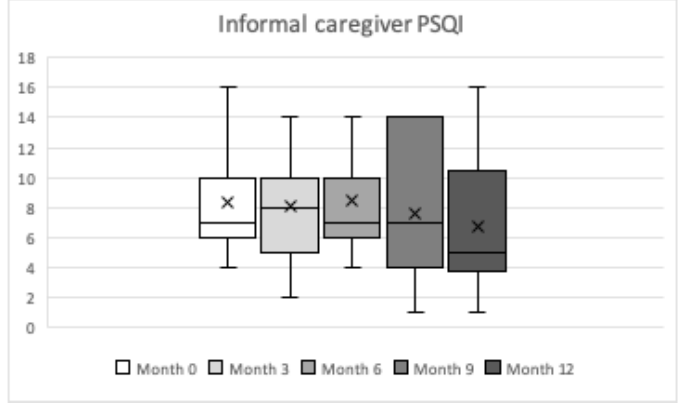
Figure 7. Informal caregivers’Pittsburgh Sleep Quality Index year progression (minimum, quartile 1, median, quartile 3,